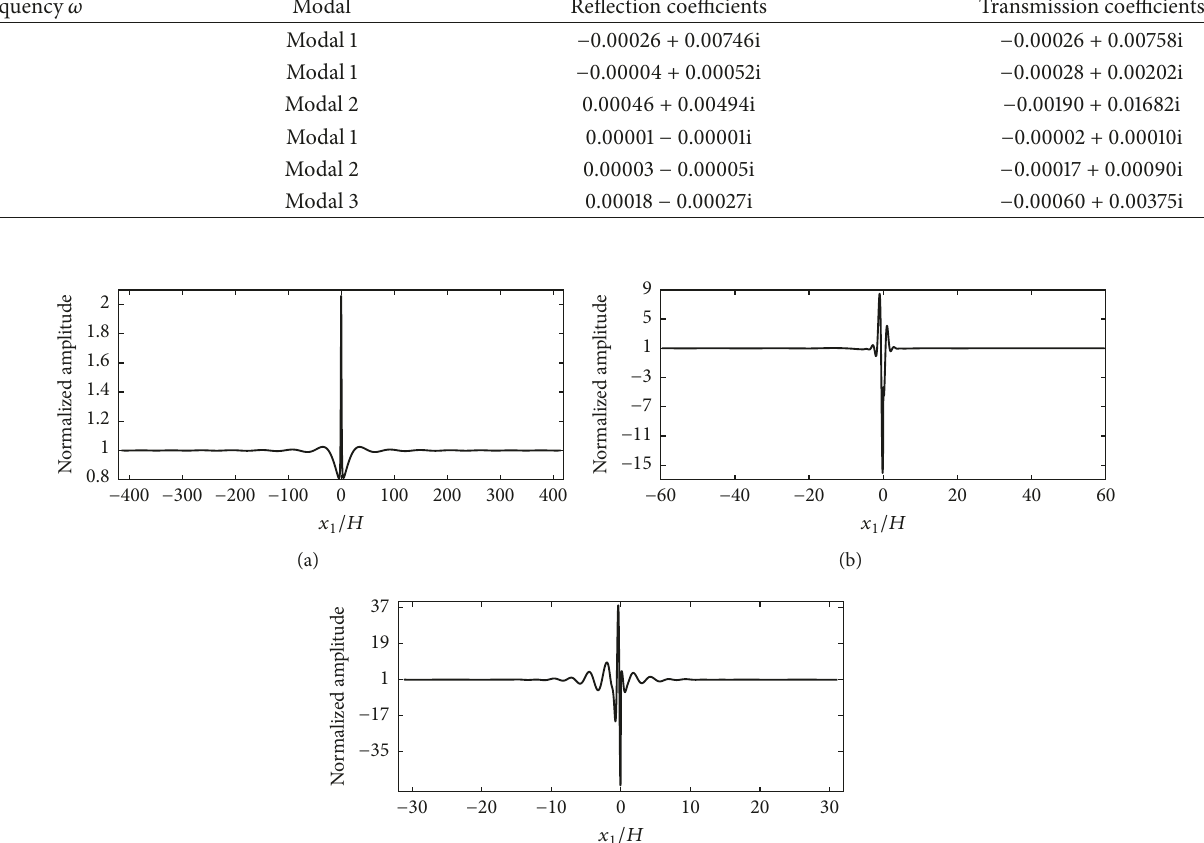
Love-wave displacement patterns are assumed on the far- field infinite boundaries previously omitted, and they are incorporated into the BEM system as the modified